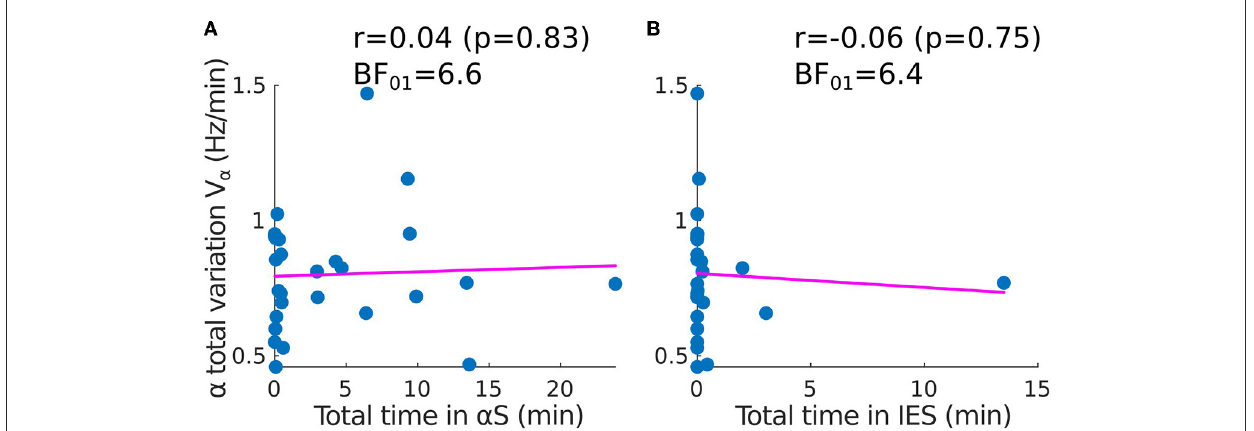
FIGURE3 Correlation between the time spent in suppressions and the total variation of the α − band (adult population). Scatter plots and correlations (Pearson r , p -value p ) between the α − band total variation V α and (A) the total time spent in α − suppressions (frequency loss in the α − band), (B) the total time spent in IES S IES .